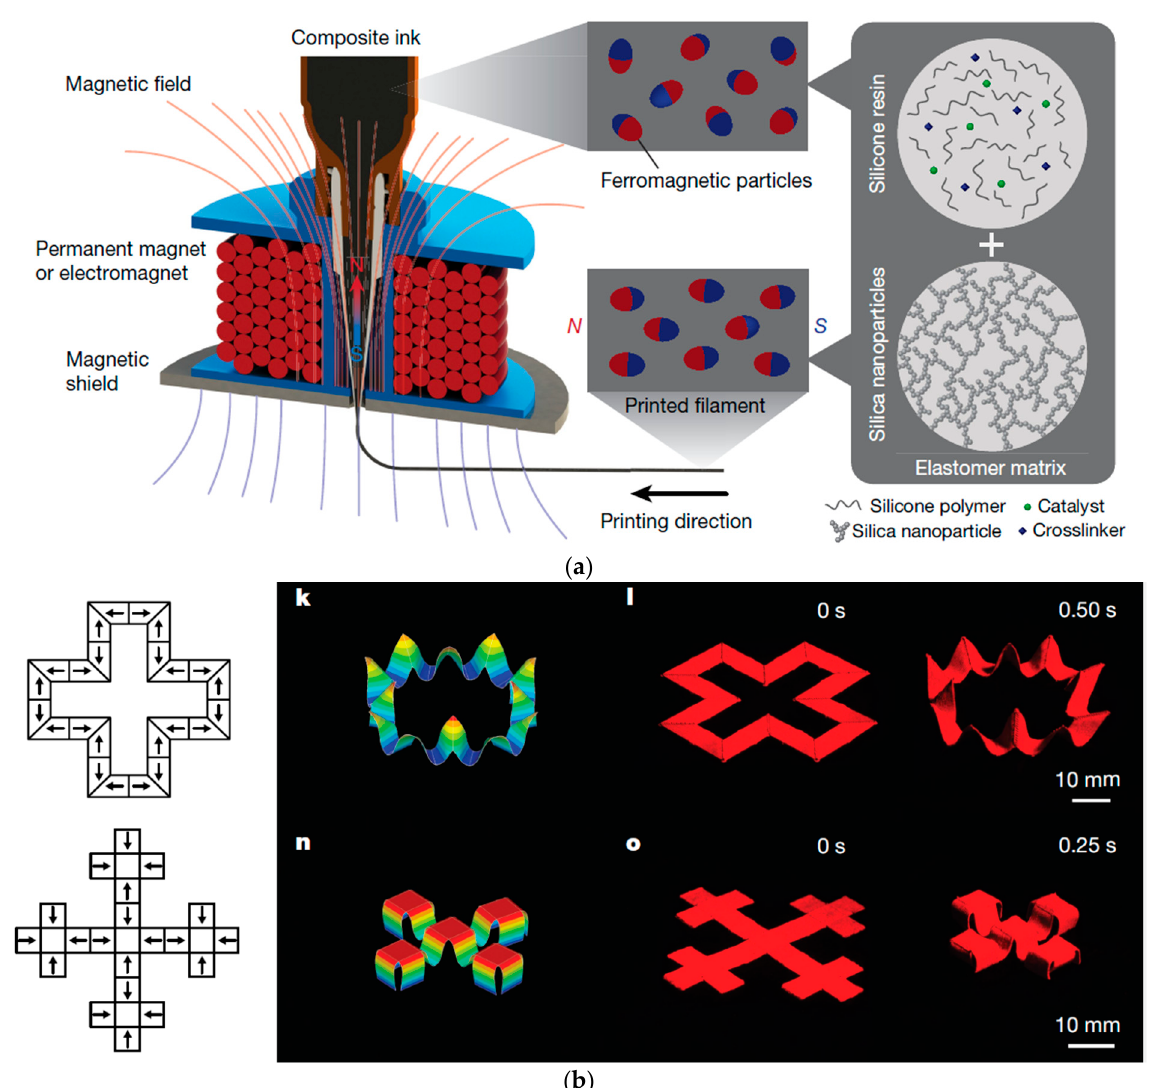
Figure 9. ( a ): The manufacturing process of magnetic soft material developed by Kim, Yuk, Zhao, Chester and Zhao [15] by which the magnetic particles oriented with the magnetic field that was applied at the nozzle. ( b ): Complex structures printed out of magnetic soft material [15] .